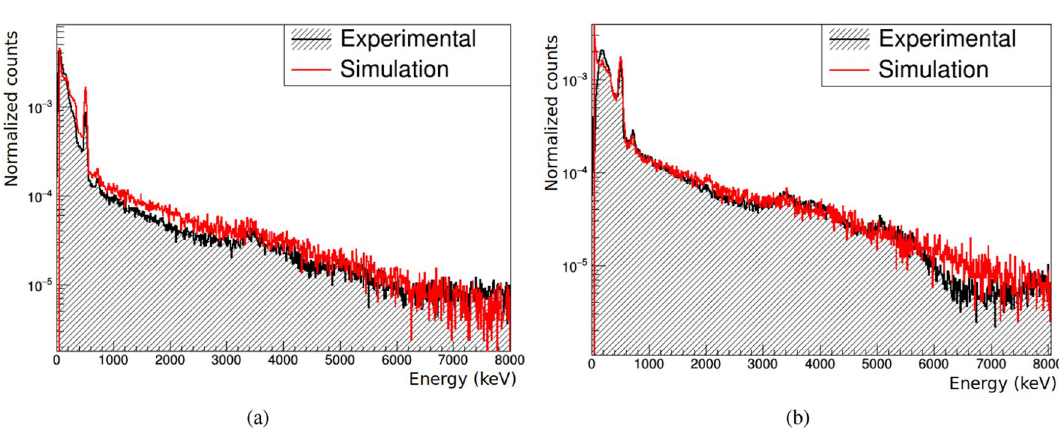
Figure 7. Experimental and simulated spectra in singles mode measured in the second ( a ) and third ( b )